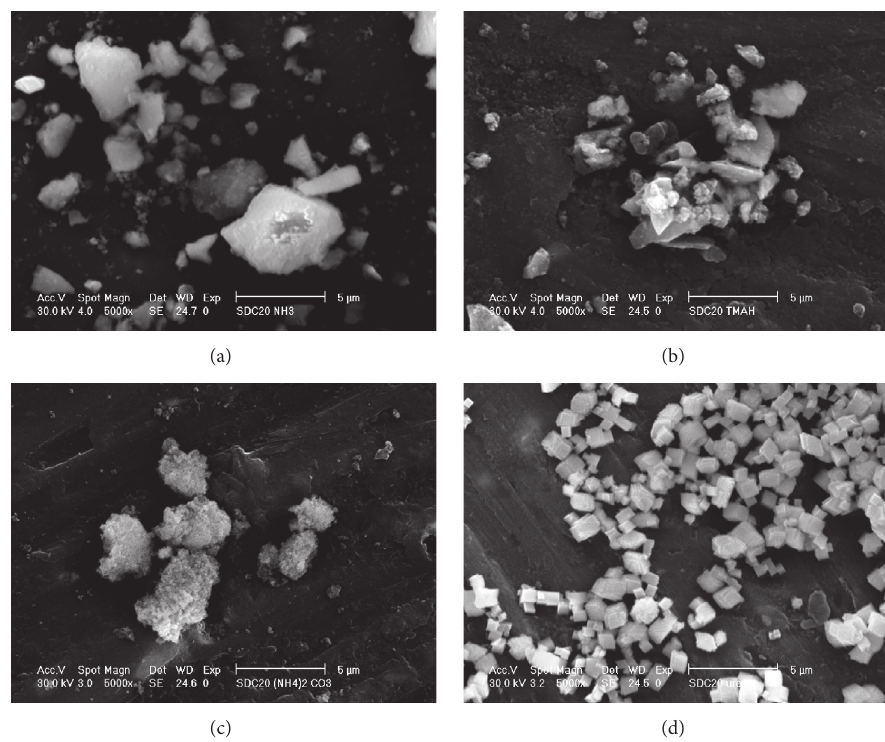
Figure 4: Morphology of the powder agglomerates after calcination: N-SDC20 (a), T-SDC20 (b), C-SDC20 (c), and U-SDC20 (d).